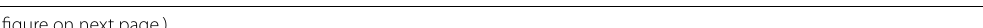
Pfiffner(See figure on next Fig. 16 Delta and lake sediments of Lake Ilanz. A Digital elevation model of Planezzas Sura. Gullies end downward at the foot of the slope suggesting that incision ceased once the lake level, resp. the delta at Planezzas was reached. B Delta sediments shed into Lake Ilanz at Planezzas east of Val da Mulin. The sediments (white arrows) overly rock avalanche deposits and are about 50 m thick. C Delta sediments shed into Lake Ilanz at Sagogn west of Val da Mulin. The sediments are stratified with a layer of boulder-sized clasts on the right. D Lake sediments (white arrow) at Ruinas da Starviz south of Sagogn in a cliff bordering the Vorderrhein (coord. 2739420/1183620). The sequence is stratified and includes fine-grained layers. Photos A.